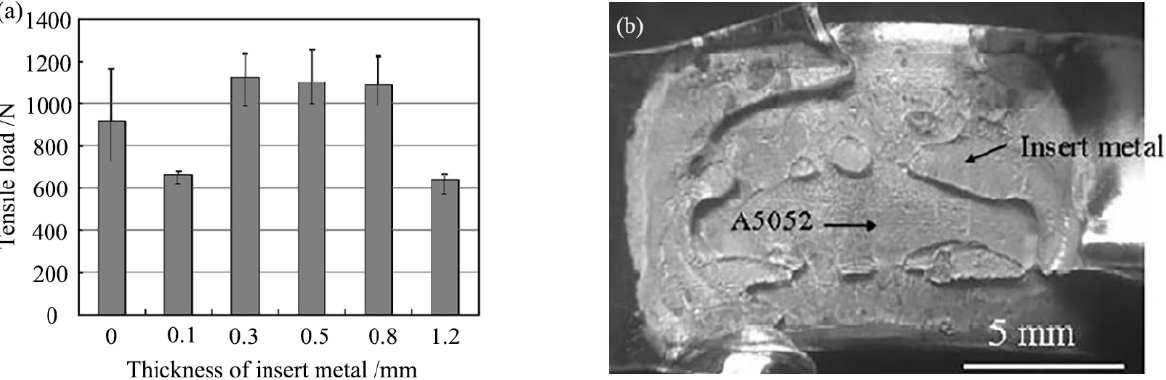
Figure 25. ( a ) The effects of the insert metal and the thickness on the joint strength; ( b ) fracture morphology of joints with the insert metal [49].